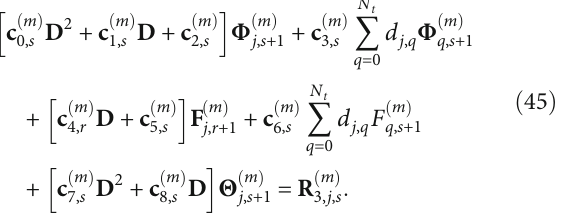
Figure 14: Concentration pro fi le for di ff erent values of Pr when De = 0 : 1, N = 0 : 5, n = 0 : 5, f = δ = NR = 0 : 2, Sc = 0 : 6, and Pr = 1 :